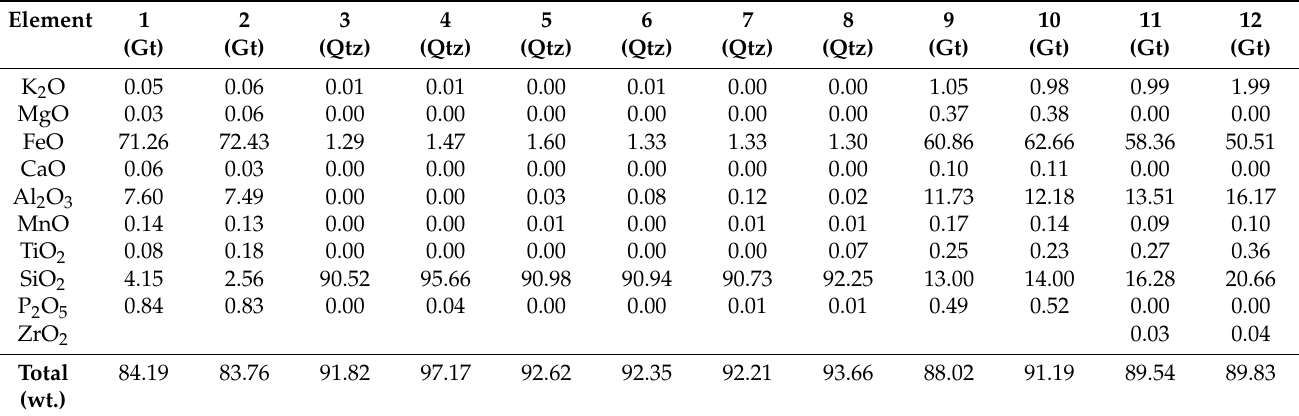
Table 1. EPMA analysis of PT09 (weight